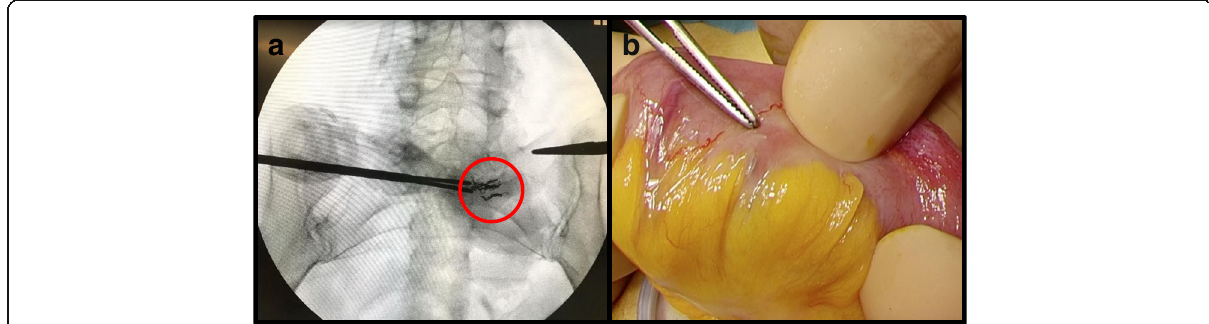
Fig. 3 Intraoperative detection of metallic coils. a X-ray fluoroscopy localizing the metallic coils (red circle) embolized under the previous angiographies. b Forceps indicating one of the metallic coils after taking out of the lesion detected under X-ray